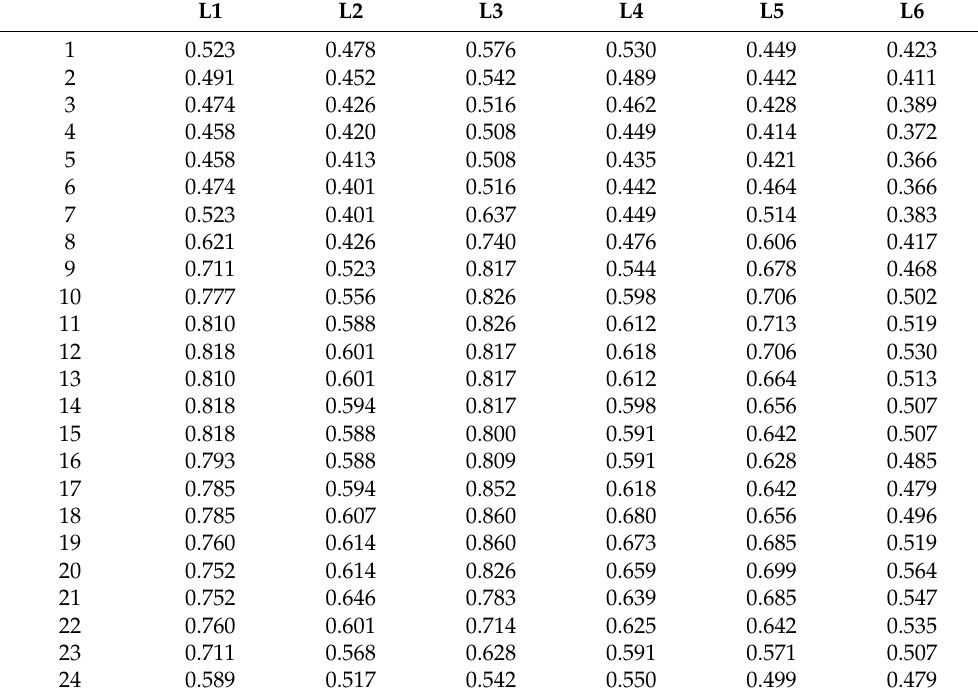
Table 2. Clusters’ representative centroids.